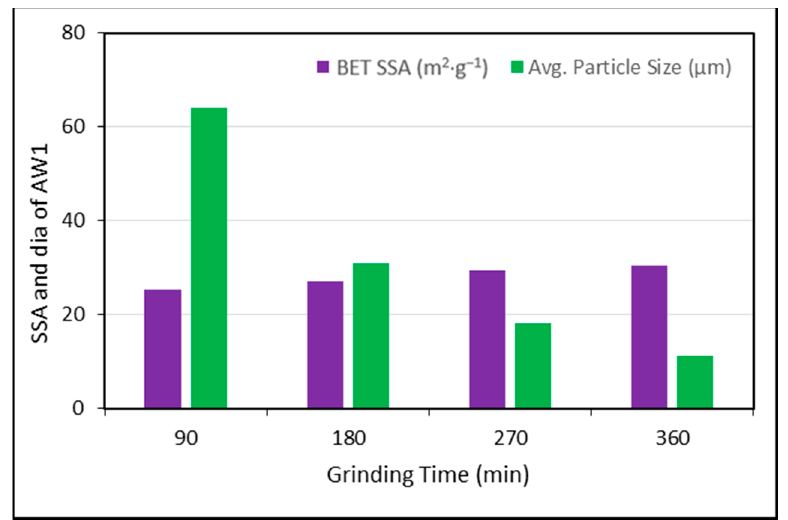
Figure 8. Evaluation of the pozzolanic involvement of RHA in SSA and particle size with grinding time.